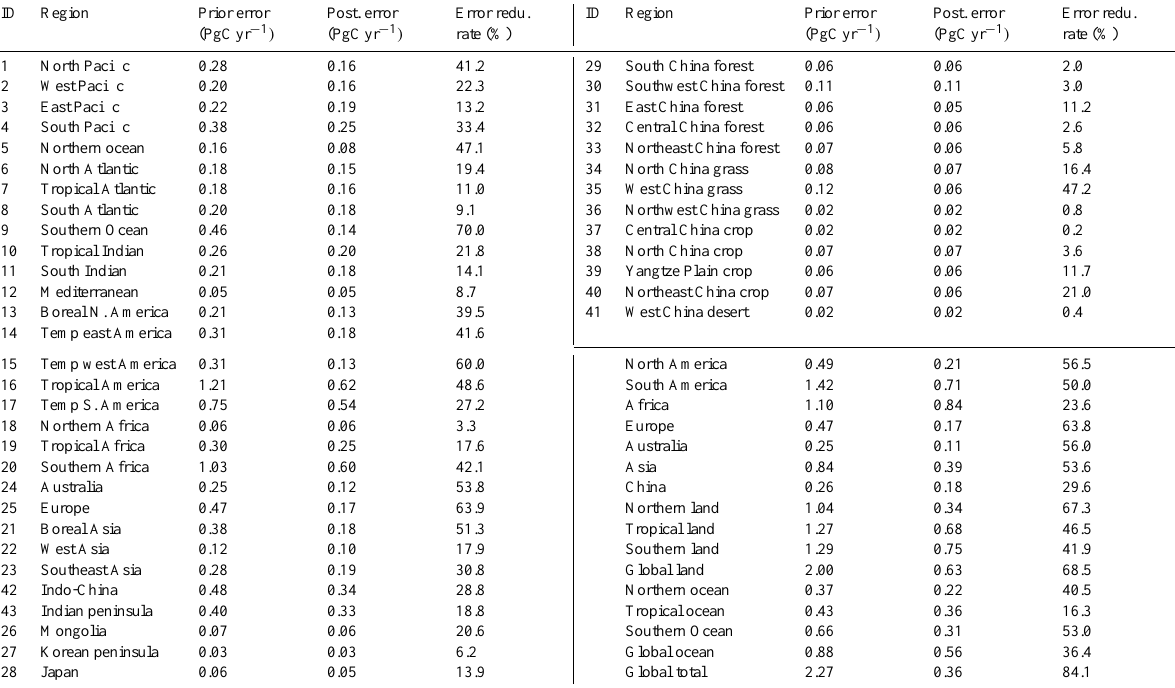
Table 1. Prior and posterior errors as well as the error reduction rates for each region. ID